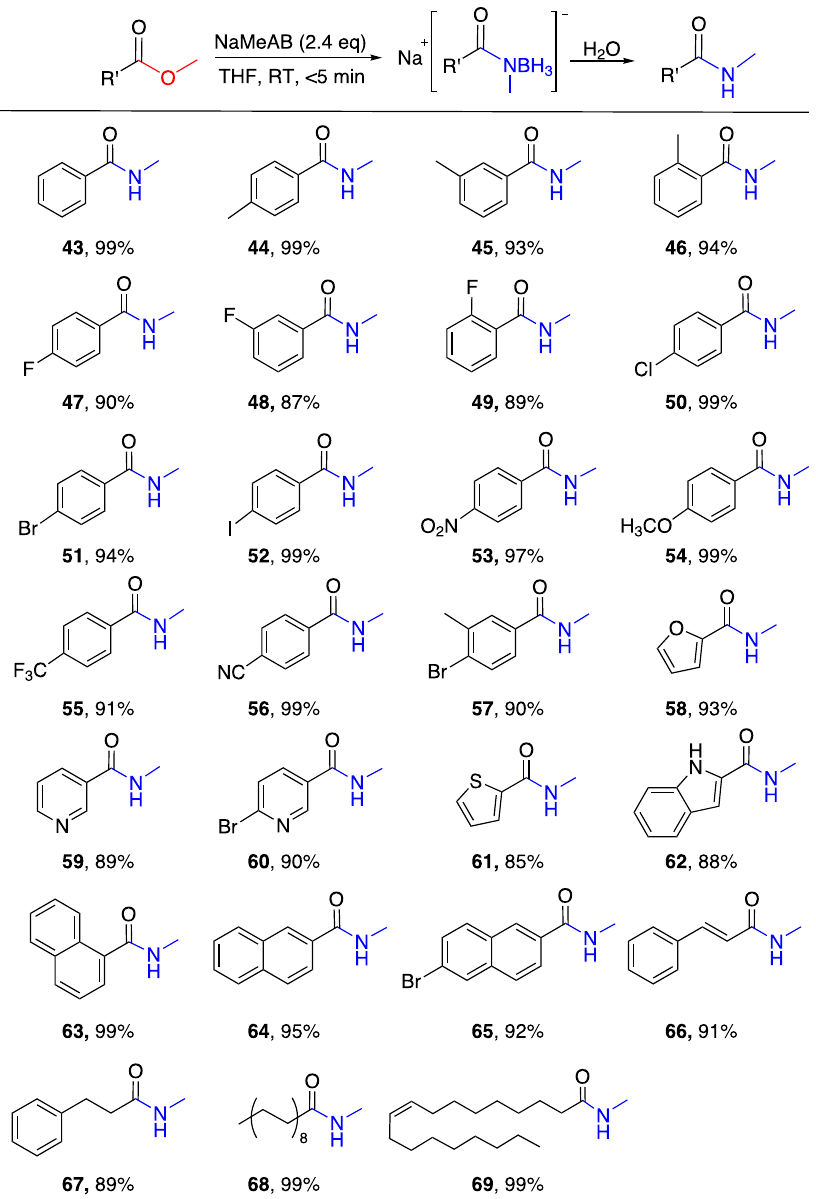
Fig. 3 Reactions of NaMeAB with various esters in THF. Reaction conditions: ester (0.5 mmol), NaMeAB (2.4 equiv), THF (5 mL), room temperature for 5 min and then